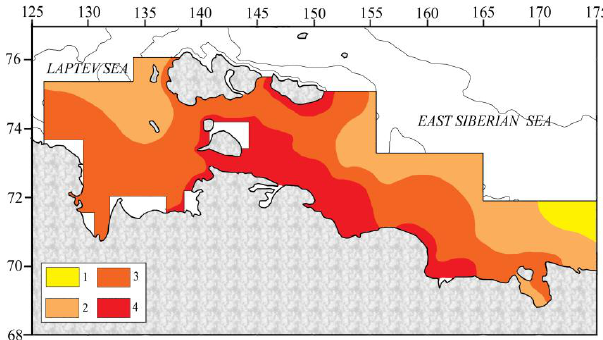
Figure 3. 1183 Fig. 3. CTOM (%) in the ESAS surface sediment: (1) < 40%,